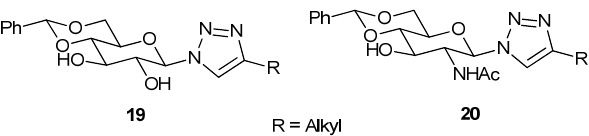
Figure 15. D ‐ Glucose and N ‐ acetylglucosamine derived triazoles.